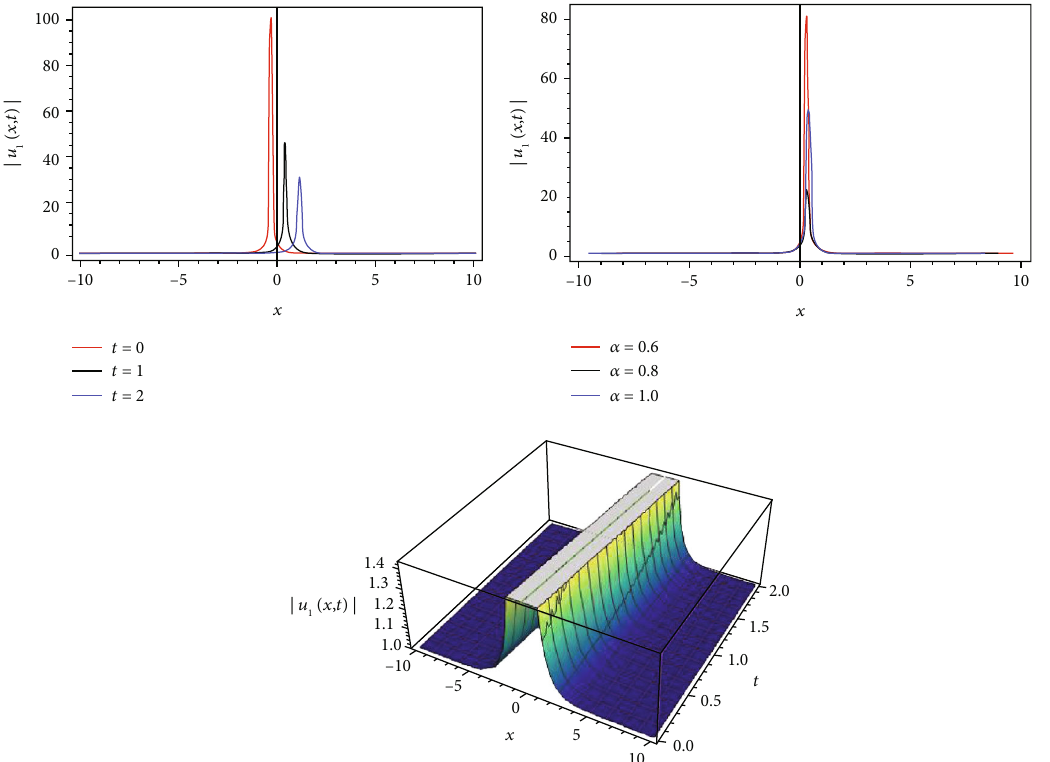
Figure 2: 2D and 3D graphics of Case 1 for hyperbolic traveling wave solution (29) at f α = 0 : 6, k = 0 : 7, q = 1, s = 1, C = − 1, c = 0 : 5 : g